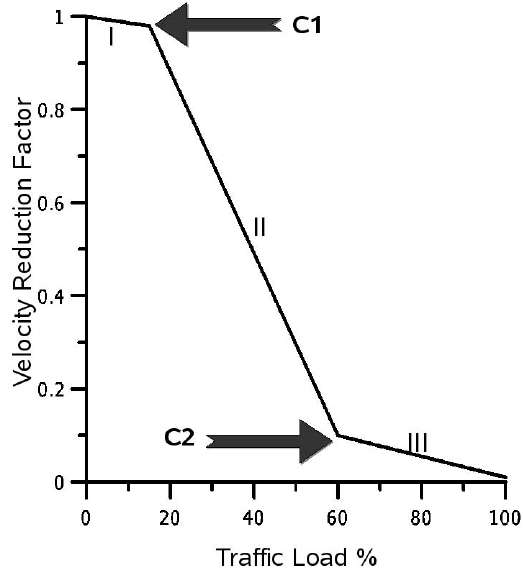
Fig. 6. During the evacuation process, the road capacity (traffic load) and the maximum speed are the parameters that determine the final speed reached in one point at each iteration. To represent this behaviour, three sections are used; I represent the maximum speed values with a low traffic density (0–20% traffic load); II simulates an abrupt fall of the speed value due to high density traffic conditions (20–60% traffic load); III represent the minimum speed values due to high traffic load values. When the load traffic is 100%, the speed value is 0. The change between one section to other is represented by two load point, C1 and C2. When the traffic load reach these values, the speed function changes.